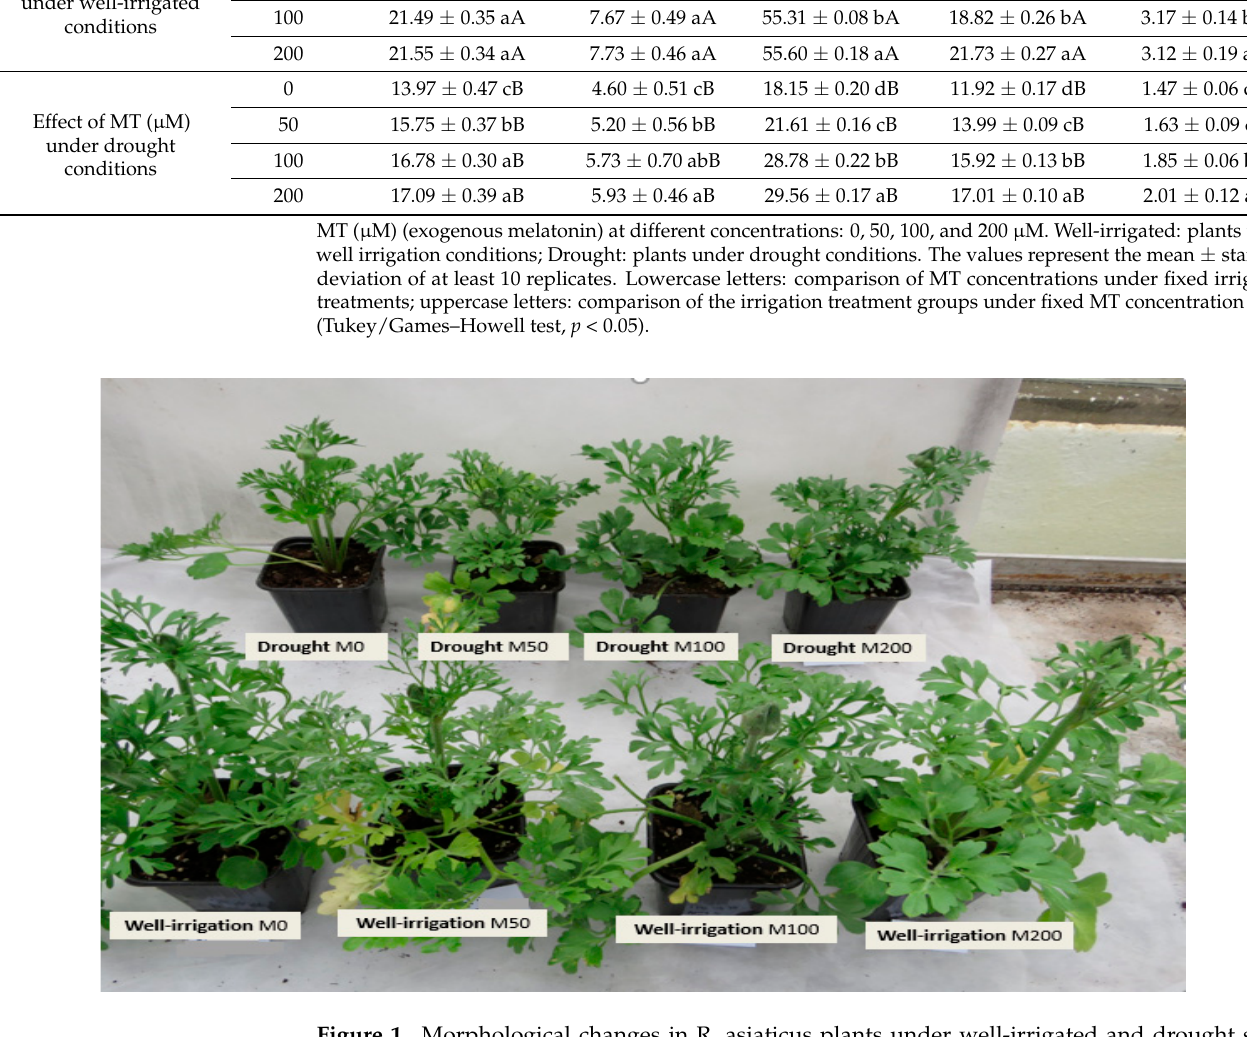
Figure 1. Morphological changes in R. asiaticus plants under well-irrigated and drought stress conditions after exogenous MT treatment.